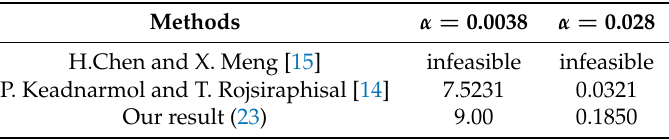
Table 9. Maximum allowable upper bounds σ for Example